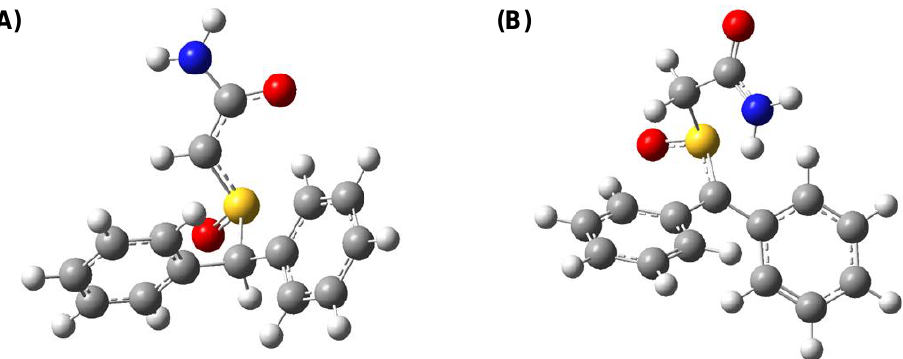
Figure 8. The structure of deprotonated armodafinil ( A ) at the C28 atom and ( B ) at the C22. C22 atom is located within the sulfinylacetamide moiety. The hydrogens in